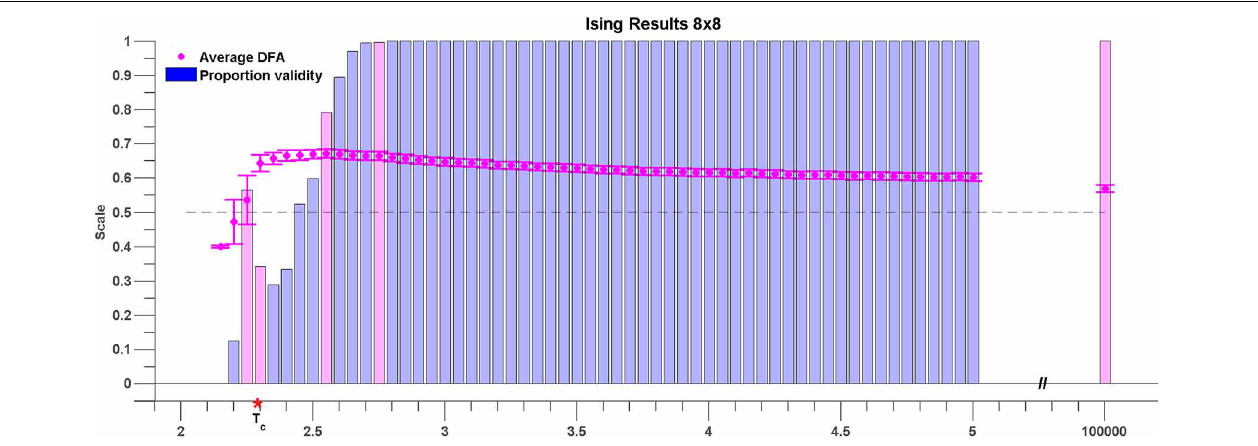
FIGURE 7 | Average DFA exponents of rate of change of phase difference between pairs of time series generated by 8 × 8 sub-lattices of the 96 × 96 Ising model lattice. The temperature parameter, T , is varied on the x axis. The average of the valid DFA exponents is shown in pink, and the error bars are a single standard